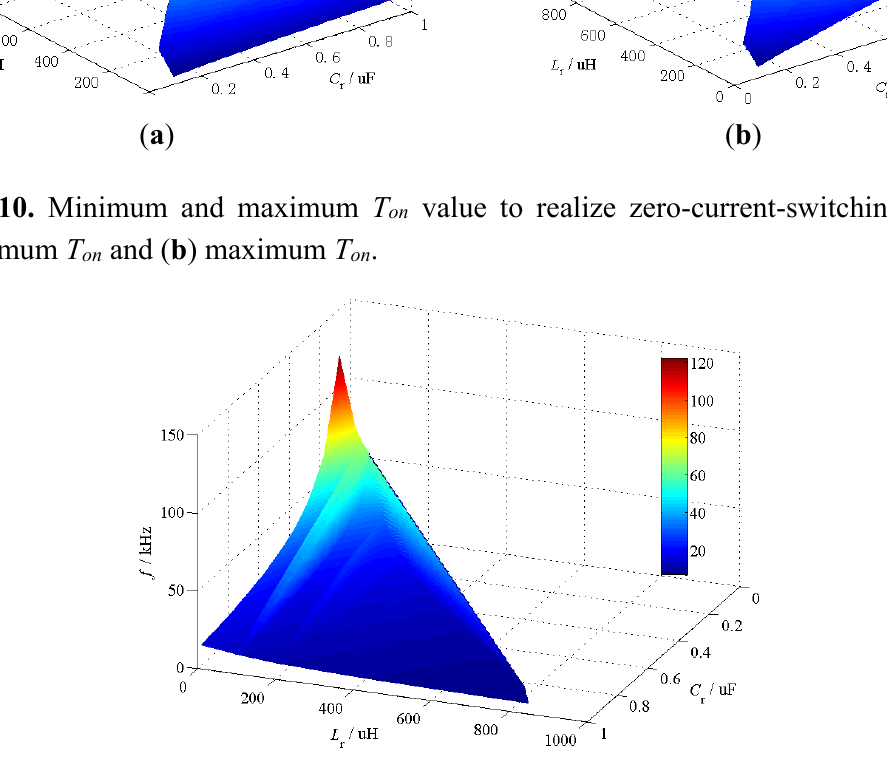
Figure 11. Driving frequency f to realize maximum output